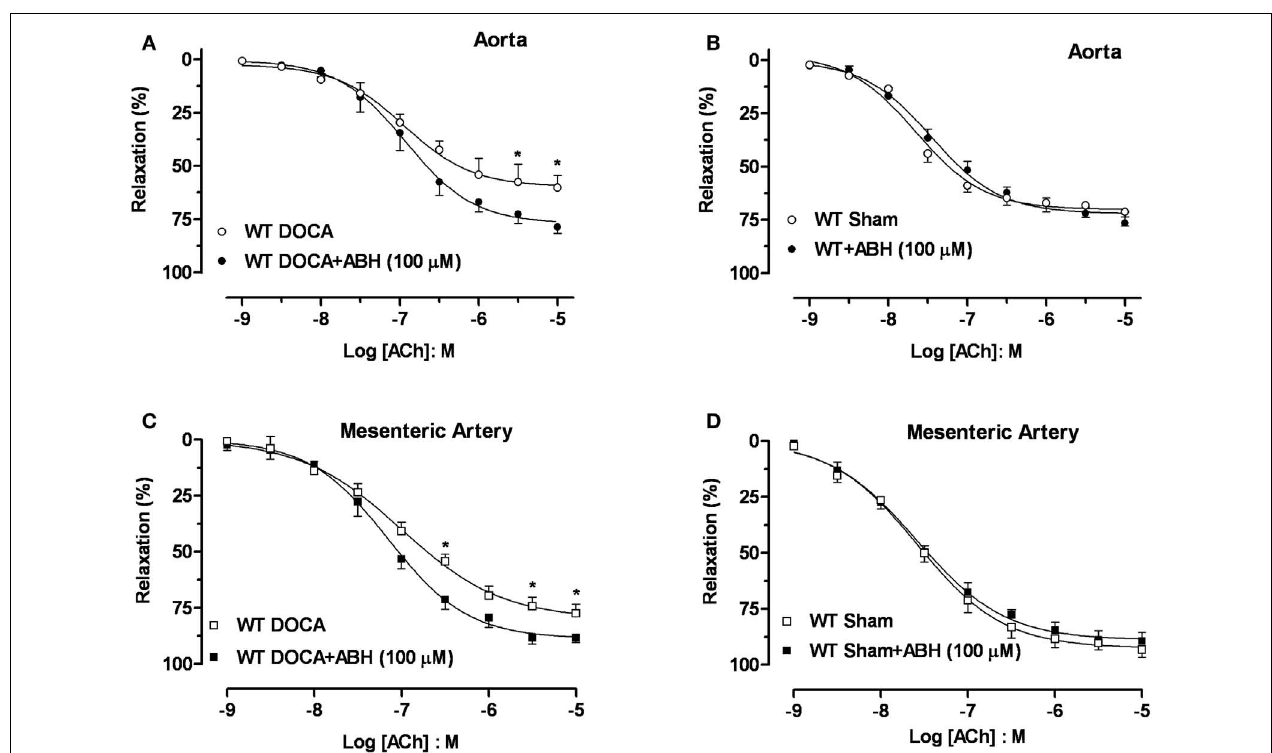
ACh-induced vasorelaxation in aorta (B) and MA (D) . Data were calculated relative to the maximal changes in contraction produced by phenylephrine (PE, 1 µ M), which was taken as 100%. Data are means ± SEM of four experiments. * P < 0.05, compared